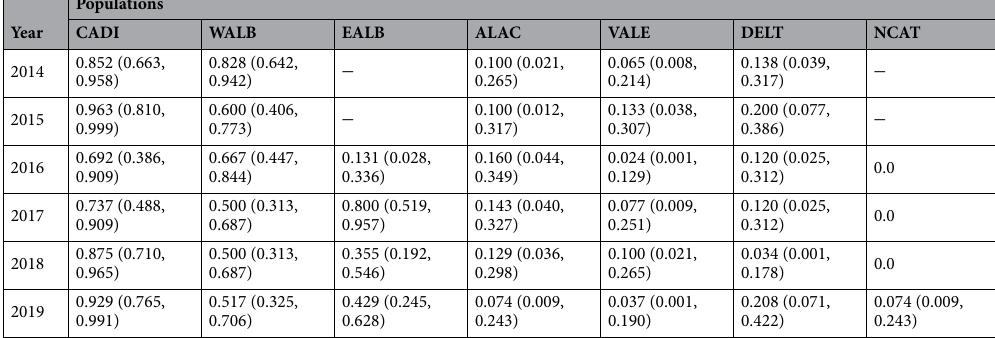
Table 1. Frequency of the ATL haplogroup in the studied populations over time. For each value, interval of confidence is presented in the row below between brackets. The population acronyms are: CADI (Cadiz), WALB (West Alboran Sea), EALB (East Alboran Sea), ALAC (Alacant), VALE (Valencia), DELT (Ebro Delta) and NCAT (North Catalonia). No samples were collected in 2014 and 2015 in EALB and